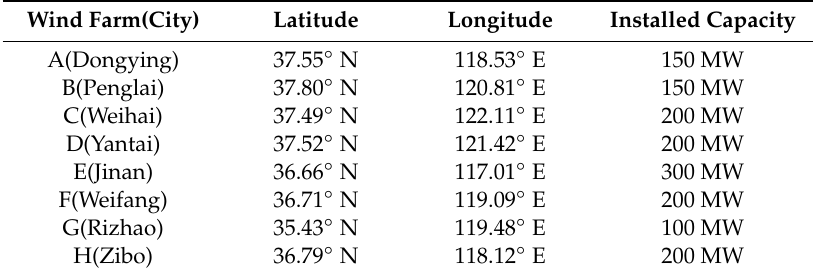
Table 2. Installed capacity and location of some wind farms in Shandong